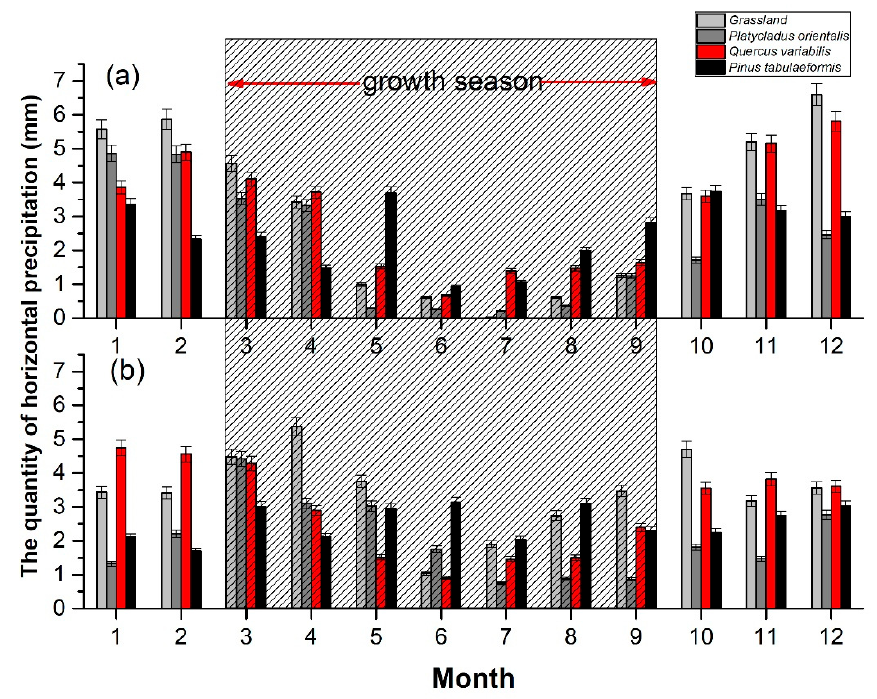
Figure 9. Monthly horizontal precipitation quantity for four forest lands from 1 January 2011 to 31 December 2012 (( a ) was 2011 and ( b ) was 2012). Data were calculated by weight changes, calculated using a weighing lysimeter system.